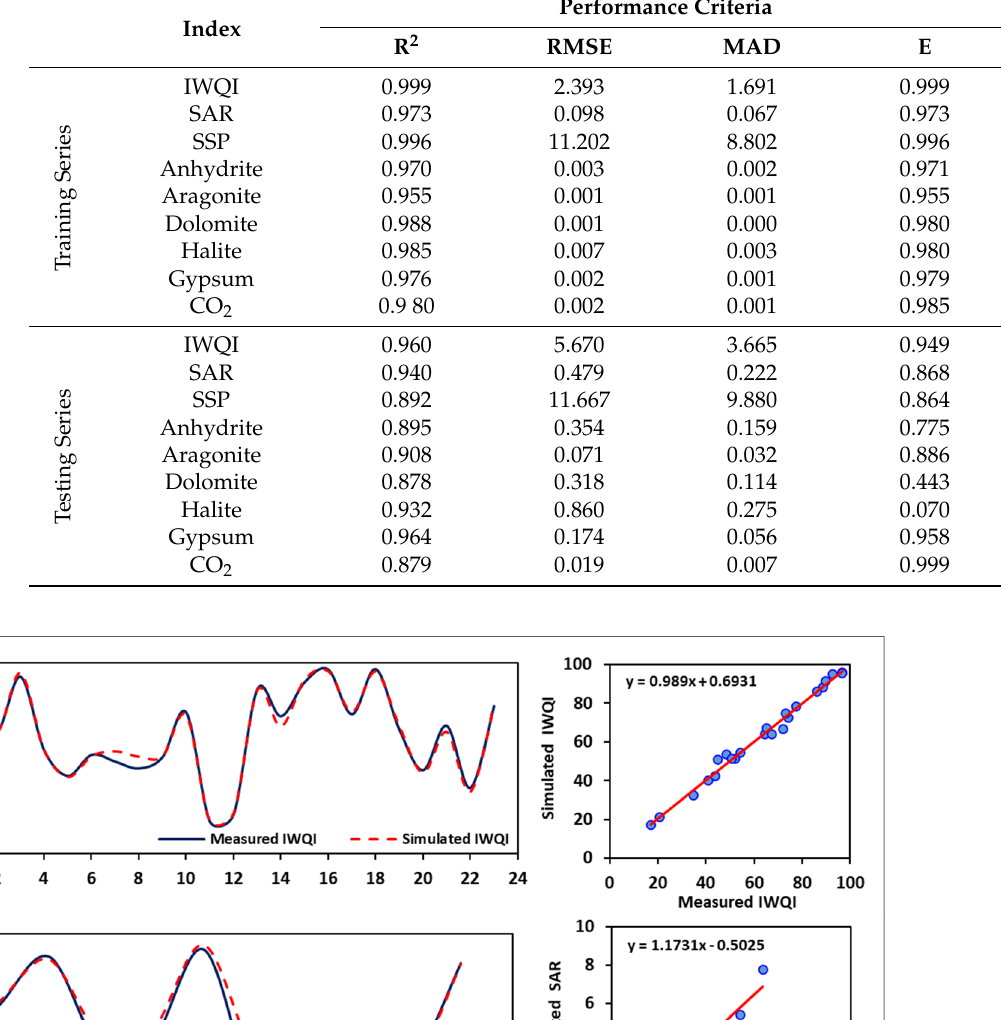
Table 7. Performance criteria of the simulation models for IWQIs prediction.